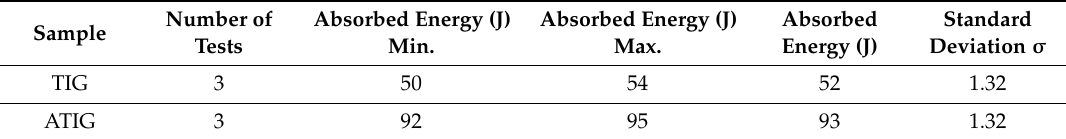
Table 10. Mesurments of energy absorbed and standards deviation of TIG and ATIG (optimal flux) at